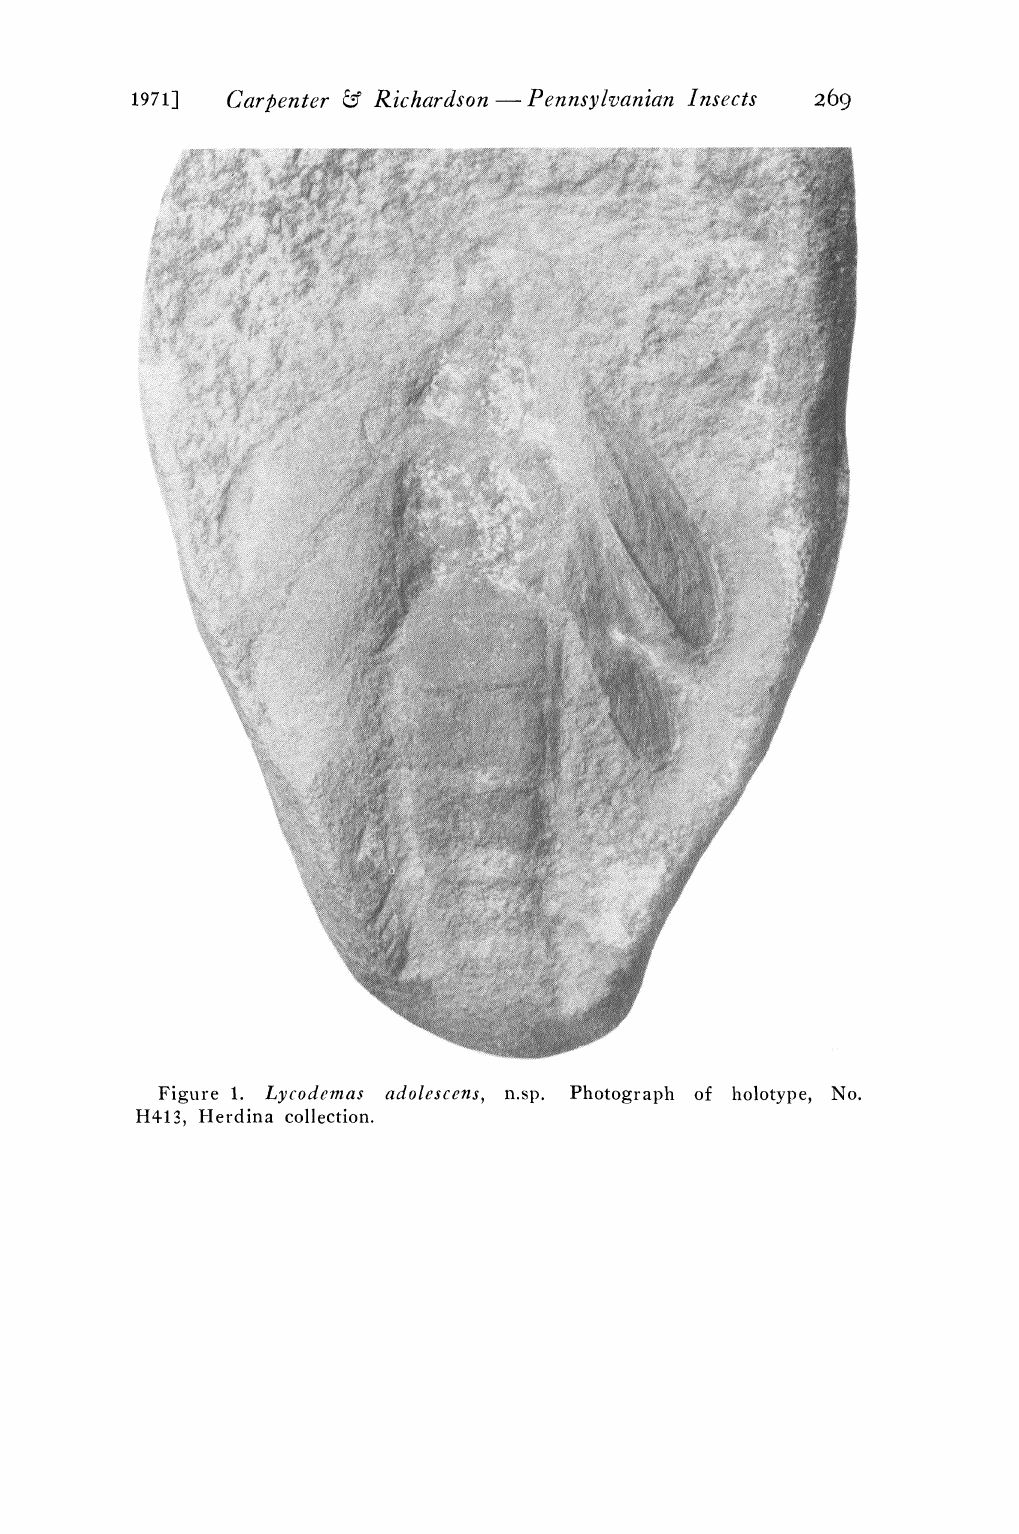
Figure 1. Lycodemas adolescens, n.sp. Photograph of holotype, No. H413, Herdina